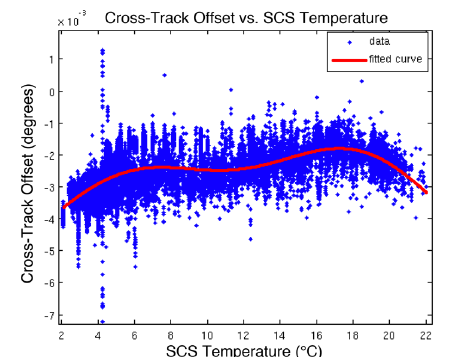
Figure 7. Best-fit curves for the cross-track offset between the NAC-L to NAC-R. Red line is a best-fit curve (2 nd order Fourier series). Y-axis units are 10 -5 degrees.